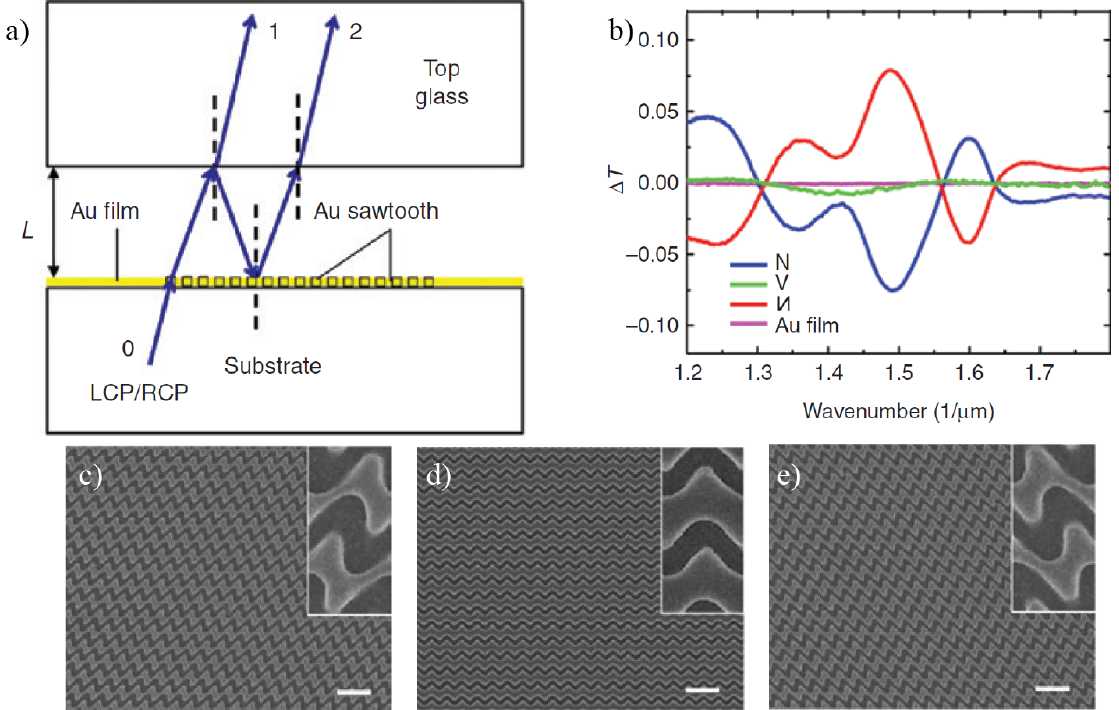
Figure 11. ( a ) Pictorial view of an Au-sawtooth metasurface surrounded by glass for circular phase-dichroism measurements. ( b ) CDT spectra from N-shaped, N -shaped, V-shaped and Au film surfaces. ( c )–( e ) The corresponding SEM images of the Au-metasurfaces. Reproduced with permission from ref. [92]. Copyright 2019 De